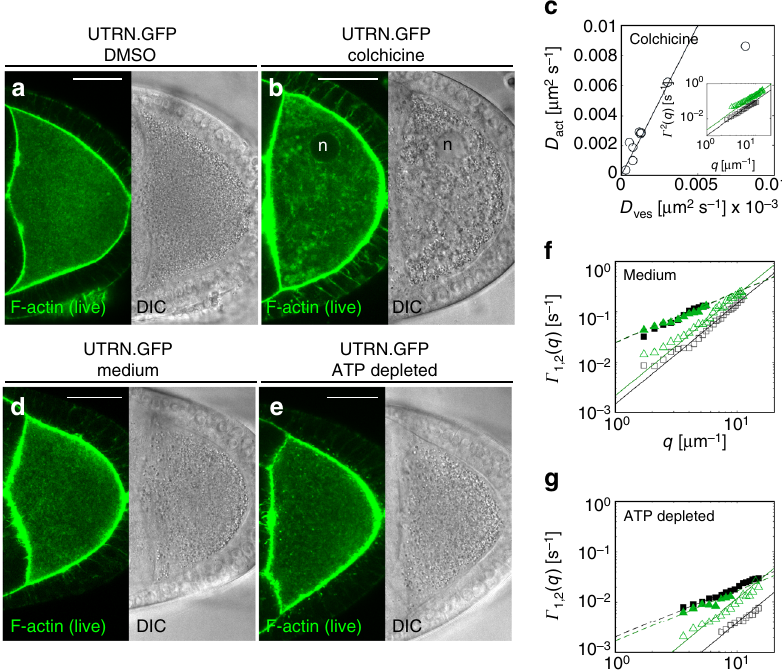
Fig. 3 Microtubules and ATP are required for advection and active diffusion. a , b Persistent motion enhances active diffusion and depends on microtubules. UTRN.GFP (green, left panel) and DIC (right panel) images from living egg chambers, obtained from females fed with DMSO ( a ) or colchicine ( b ). The ef fi ciency of colchicine feeding was assured by using only cells that displayed a nucleus (n) detached from the anterior membrane (compared to Fig. 2a). Depolymerization of microtubules, and consequently the absence of fl ows, causes a heterogeneous distribution of vesicles. At the same time, prominent actin fi laments can be observed traversing the cytoplasm (see also Supplementary Movie 2). c D act as a function of the diffusion D ves . In the absence of persistent fl ows the diffusivity of both, F-actin and vesicles, is reduced. However, the diffusion coef fi cients still maintain a linear relation with each other (solid line corresponds to D act = 2 D ves ). Each data point represents one cell. The inset shows the diffusive relaxation rates Γ 2 ( q ) measured for F-actin (green triangles) and vesicle (black boxes) in a representative experiment on a single cell. Continuous lines are best fi ts to the data with a quadratic function. d , e Cytoplasmic motility is driven by active processes. UTRN.GFP (green, left panel) and DIC (right panel) images from living egg chambers treated with control medium ( d ) or sodium azide and 2- D -deoxyglucose to deplete ATP ( e , see also Supplementary Movie 4)). f Γ 1 ( q ) (empty symbols) and Γ 2 ( q ) (solid symbols) measured in a representative control cell (treated with medium). Green triangles correspond to F-actin, while gray squares correspond to vesicles. Continuous and dashed lines are best fi ts of the data to a quadratic or a linear function, respectively. g Γ 1 ( q ) and Γ 2 ( q ) obtained from ATP-depleted cells plotted against the wave vector q . Color code as in f . Compared to controls, the dynamics of ATP-depleted cells is more than one order of magnitude slower. Scale bar is 30 µ